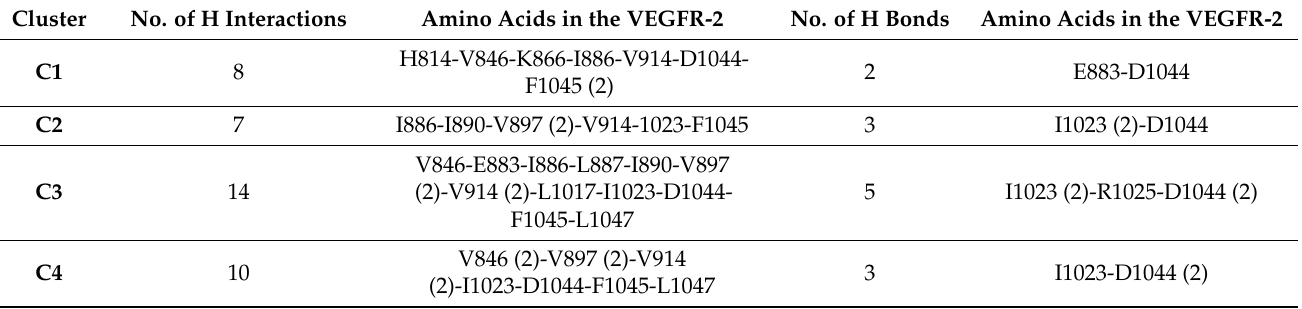
Table 1. The No. and types of interactions between compound 10-VEGFR-2 complex as obtained from PLIP webserver for the representative frame of each